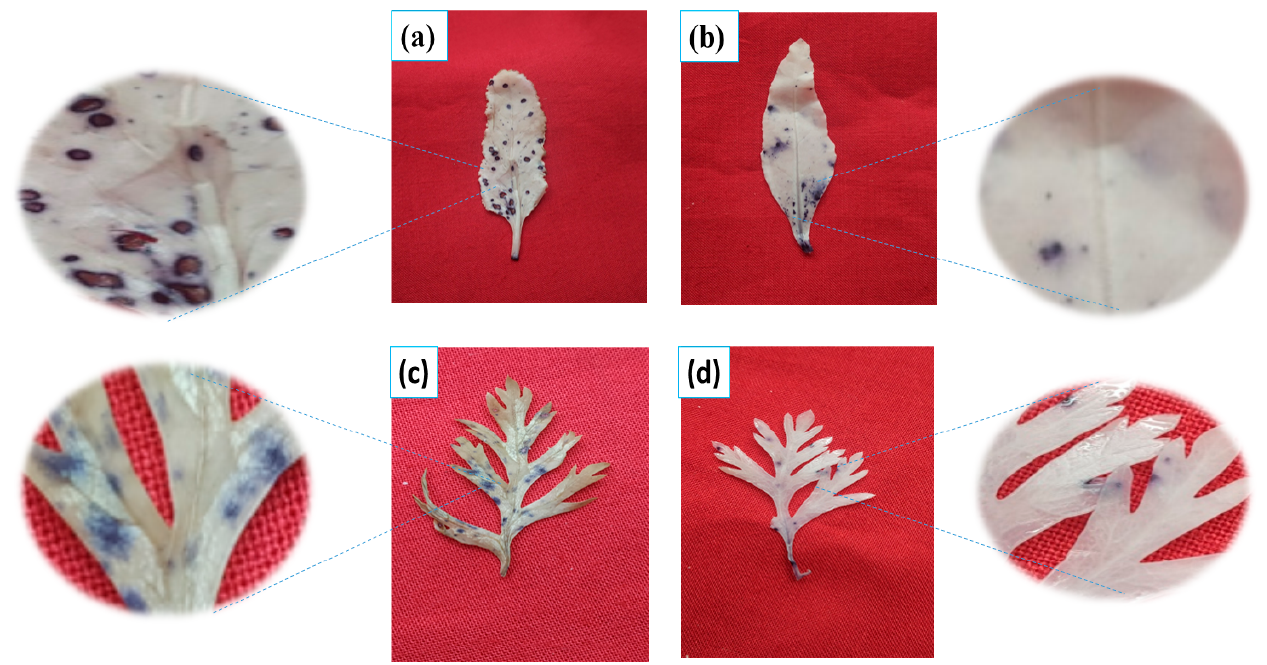
Figure 7. Impact of different N levels on the generation of superoxide radicals (and their histochemical localization in the leaves of beetroot at control ( a ) and U150 ( b ) and carrot at control ( c ) and U150 ( d ).